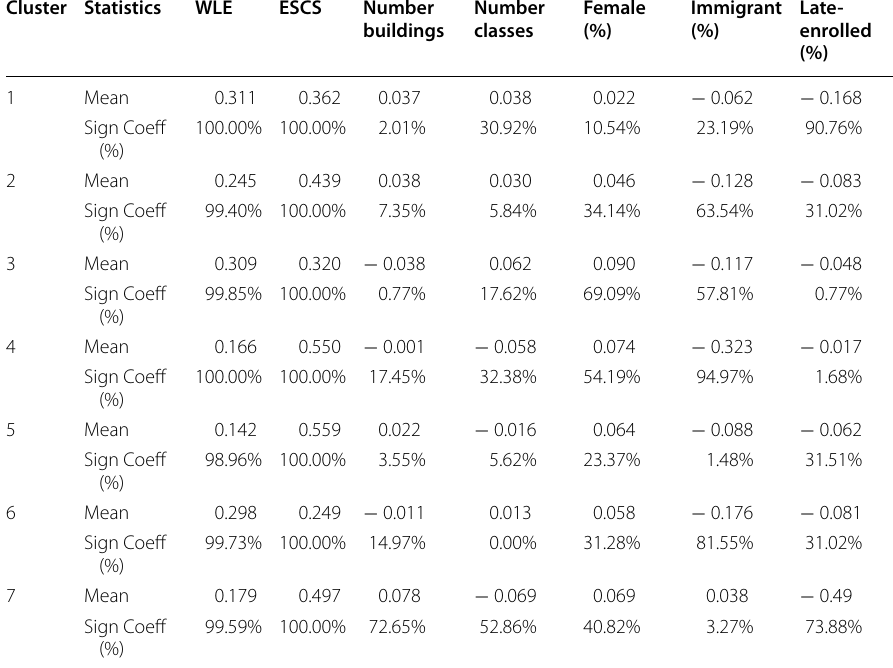
Table 5 Mean and percentage of significant coefficients for each cluster and for each predictor Cluster Statistics